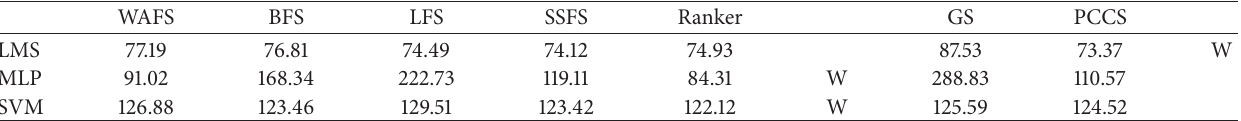
Table 3: Achieved MAE after applying various wrapper selection methods on LMS, MLP, and SVM. WAFS BFS LMS